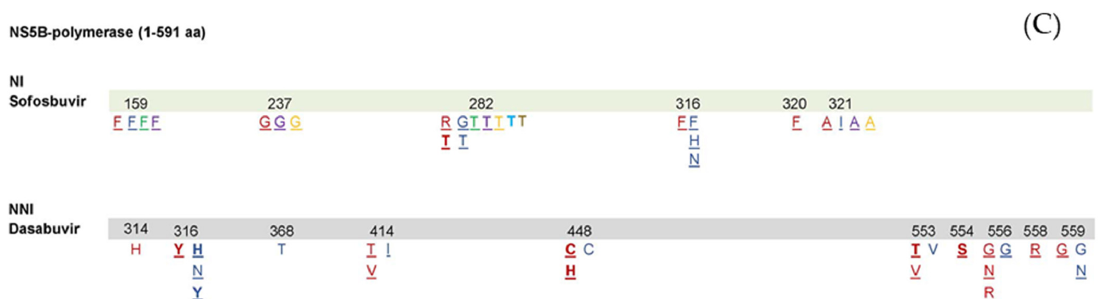
Figure 2. Summary of substitutions associated with resistance to protease inhibitors ( A ), NS5A inhibitors ( B ), and nucleoside and non-nucleoside NS5 B inhibitors ( C ). HCV genotypes and subtypes are represented by different colors: 1a–red, 1b-blue, 2a/b/c–green, 3a–purple, 4a/d–yellow, 5–light blue, 6–brown. Amino acid substitutions detected in vivo in DAA failing patients are underlined, independently of in vitro data information. From Ref. [28]; Sorbo, M.C.; et al. Drug Resistance Updates 2018; 37, 17–39 (permission from the original copyright holder).